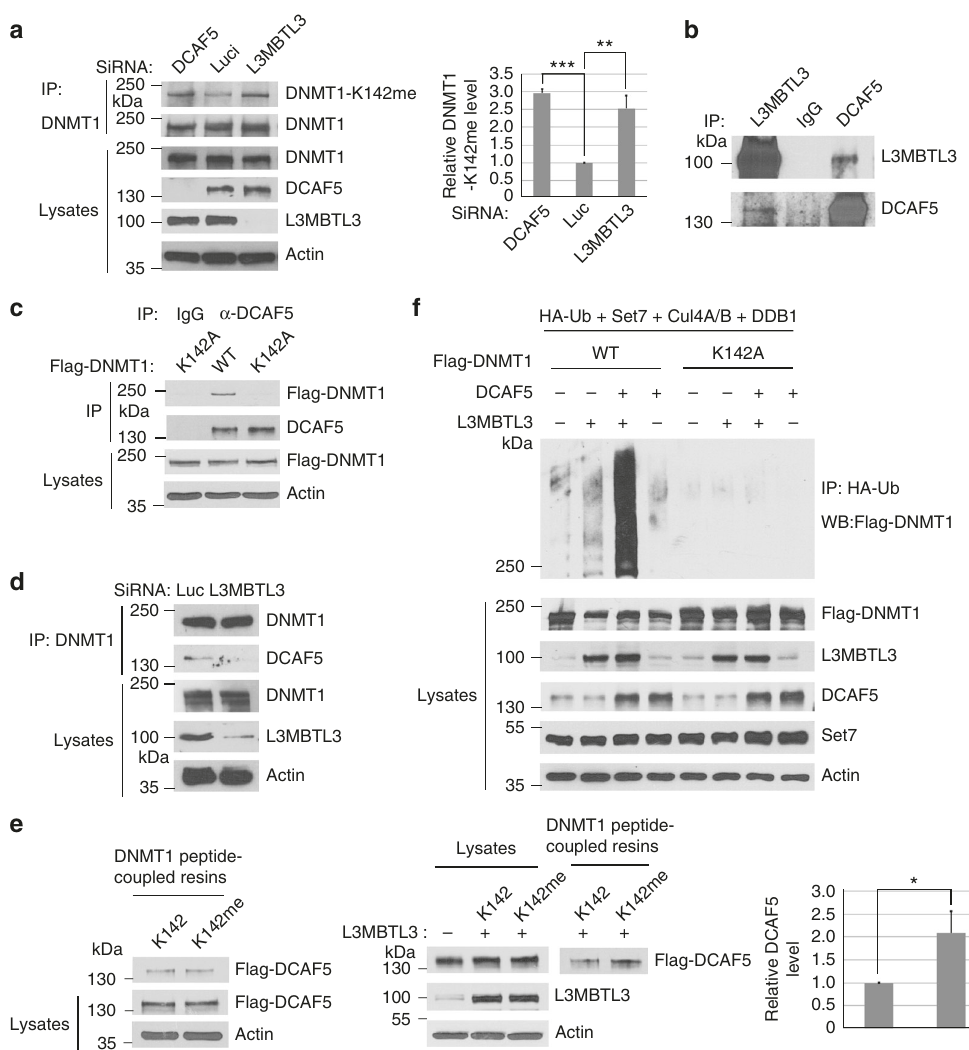
Fig. 6 L3MBTL3 interacts with CRL4 DCAF5 and recruits DCAF5 onto the methylated DNMT1 protein. a Downregulation of DCAF5 or L3MBTL3 increases the K142-methylated DNMT1. HCT116 cells were transfected with 50 nM of control, DCAF5 and L3MBTL3 siRNAs. DNMT1 was immunoprecipitated by anti-DNMT1 antibody and western blotted by anti-methylated K142 or anti-DNMT1 antibodies. Student ’ s t -test was caculated for signi fi cant differences. ** P < 0.01 and *** P < 0.001. b L3MBTL3 and DCAF5 interact. Endogenous DCAF5 and L3MBTL3 proteins were immunoprecipitated from HCT116 cells and western blotted with indicated antibodies. c The interaction between DCAF5 and DNMT1 is abolished by K142 mutation. Flag-WT-DNMT1 and its K142A mutant constructs were transfected into HCT116 cells and the interactions between DCAF5 and Flag-DNMT1 or the K142A mutant were analyzed by anti- DCAF5 immunoprecipitation and western blotting with anti-Flag and DCAF5 antibodies. d Downregulation of L3MBTL3 abolished the interaction between DNMT1 and DCAF5. Endogenous DNMT1 and DCAF5 proteins were immunoprecipitated by anti-DNMT1 antibodies from control and L3MBTL3 siRNA- mediated knockdown cells (42 h of siRNA and MG132 for additional 6 h). The immunoprecipitated proteins were blotted with anti-DCAF5 and DNMT1 antibodies. e L3MBTL3 is required for preferential binding of DCAF5 to the monomethylated K142 peptide. HCT116 extracts expressing a stable Flag- DCAF5 or Flag-DCAF5 and L3MBTL3 were prepared. 250 μ g extract proteins were incubated with the monomethylated K142 or the cognate unmethylated peptide resins as in Fig. 5c. The binding of Flag-DCAF5 to the peptide resins with or without L3MBTL3 were examined by anti-Flag and L3MBTL3 antibodies. Student ’ s t -test was used for signi fi cant differences. *P < 0.05. f L3MBTL3 and CRL4 DCAF5 target DNMT1 for polyubiquitination in vivo. Flag-WT DNMT1 and Flag-K142A mutant expressing constructs were co-transfected into 293 cells together with vectors expressing HA-tagged ubiquitin (HA-Ub), SET7, CUL4A, CUL4B, and DDB1, in the presence or absence of L3MBTL3 and DCAF5 expressing constructs as indicated. Proteins were immunoprecipitated with anti-HA antibodies and western blotted with the anti-Flag-DNMT1 antibodies as indicated. Quanti fi cations for all experiments were represented by bar graph with mean and S.D. for error bars from three replicates and Student ’ s t-test was used for signi fi cant differences,